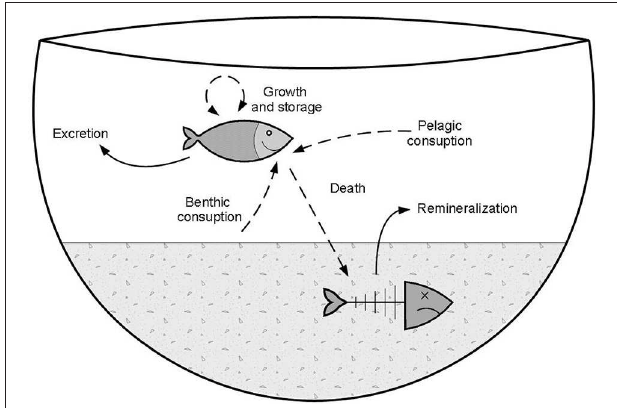
FIGURE 1 | Conceptual model showing the fluxes of nutrients derived from fish (sources to the water column, solid arrows) and stored in fish biomass (sinks from the water column, dashed arrows). Fish can act as nutrient sinks when they remove nutrients from circulation and store them in their bodies for growth, or when fish die and nutrients are stored in recalcitrant tissues. On the other hand, they act as sources of nutrients to the water column when they are releasing nutrients through excretion and remineralization of nutrients stored in carcasses. Piscivory is omitted here for